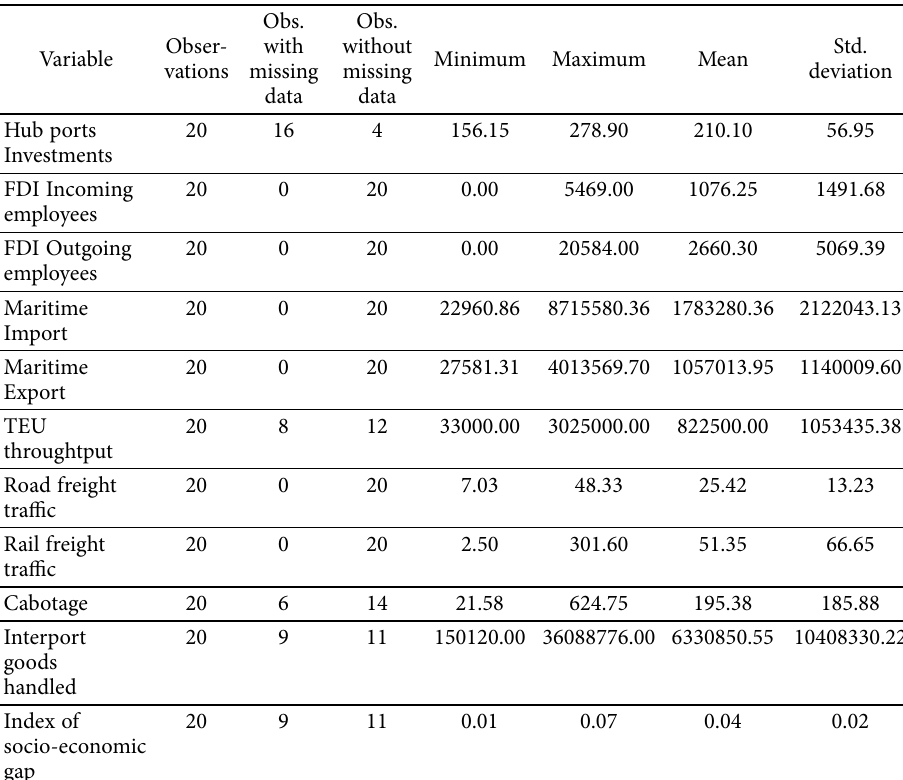
Table 3. Summary statistics NUTS2 level